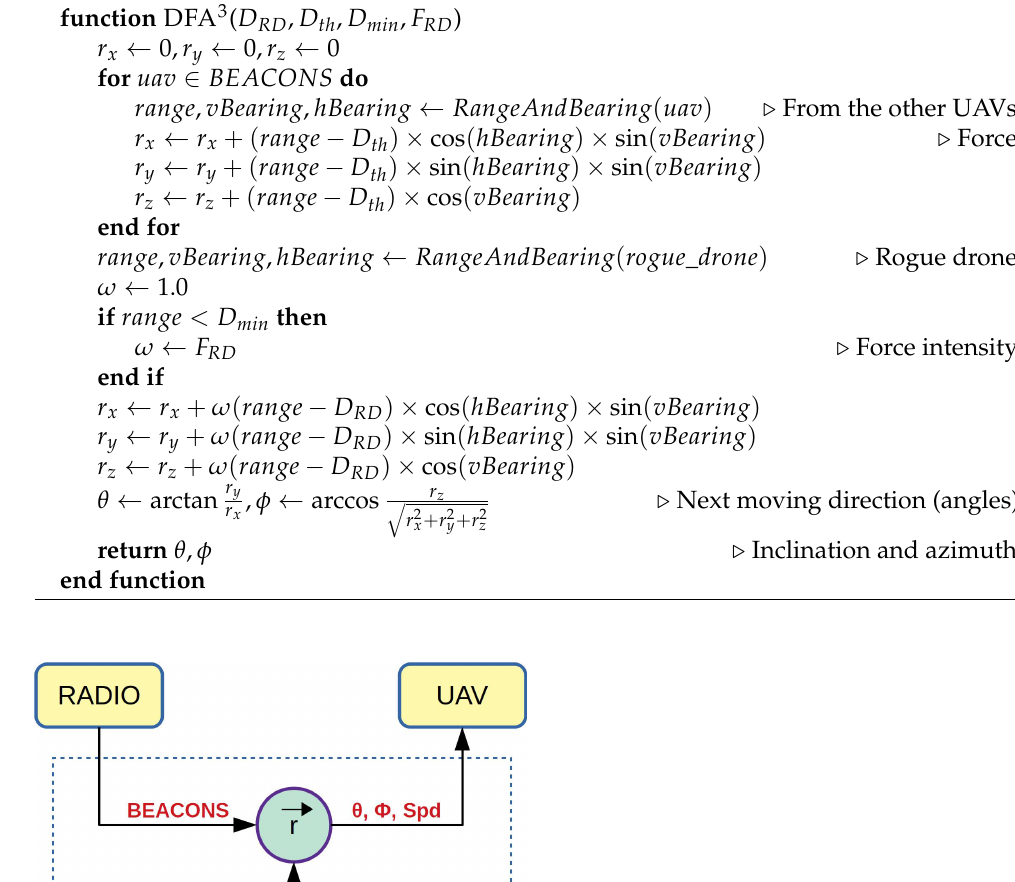
Algorithm 1 Distributed formation algorithm 3 (DFA 3 ).